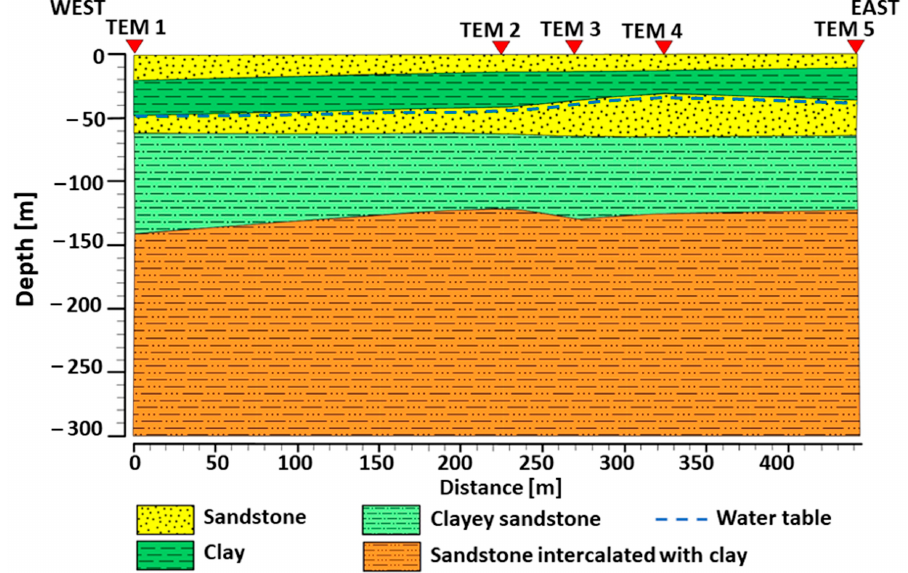
Figure 7. The northern electromagnetic cross-section in the study area.